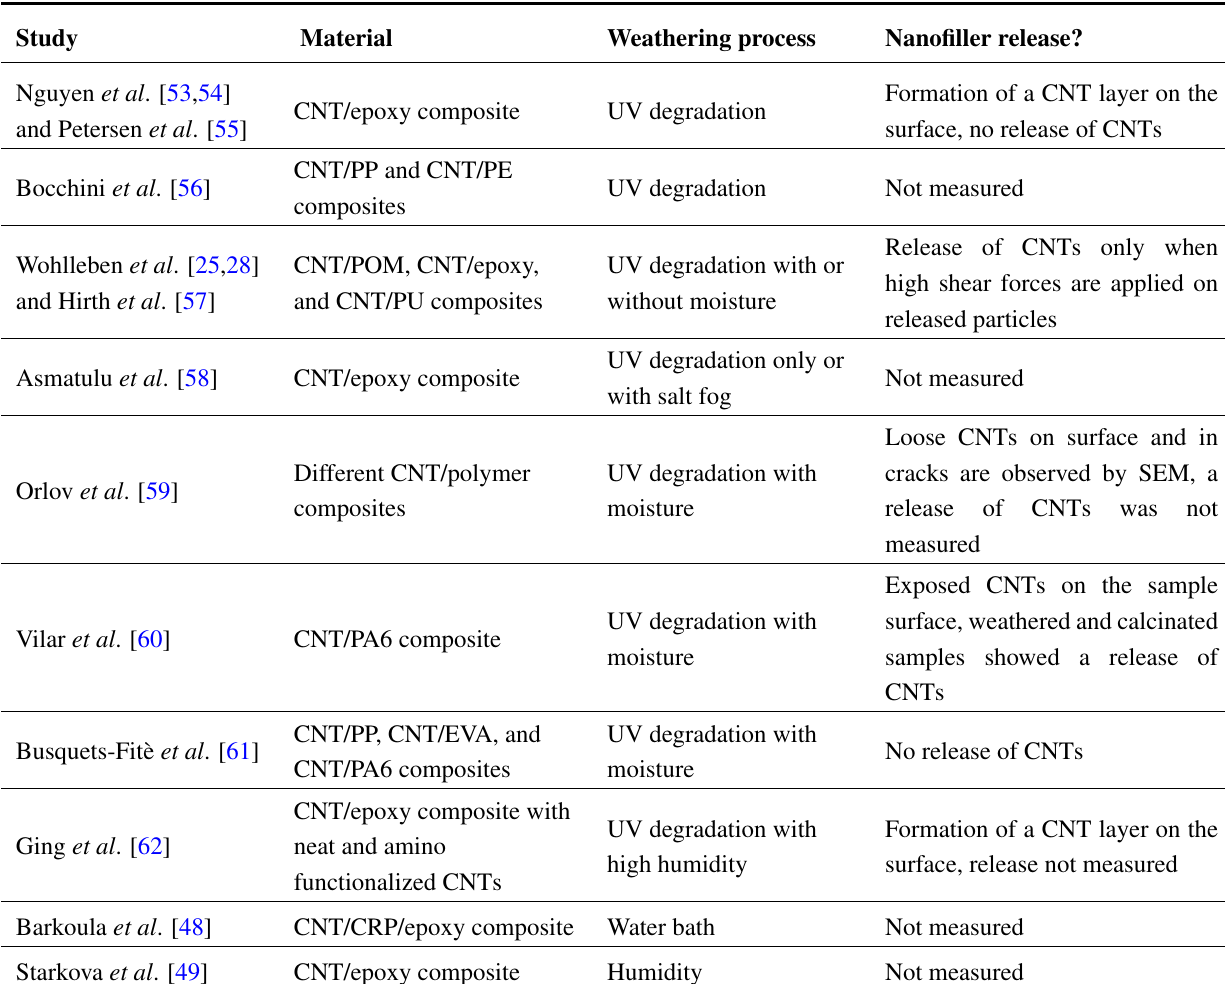
Table 3. CNT release